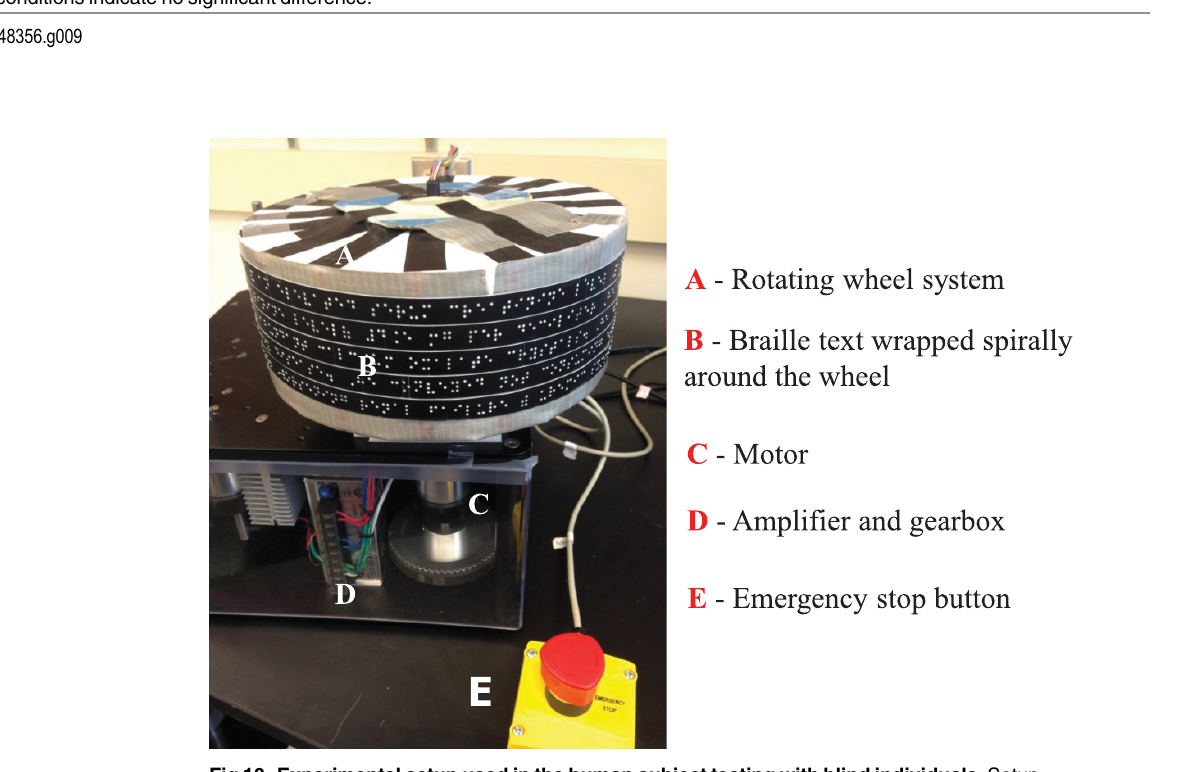
Fig 9. Mean workload metrics for different experimental conditions performed in TE. Results are based on NASA – TLX. Error bars represent standard error. Different letters on bars indicate statistical significance in pairwise comparisons performed with Bonferroni post-hoc tests. Letters shared in common between experimental conditions indicate no significant difference.